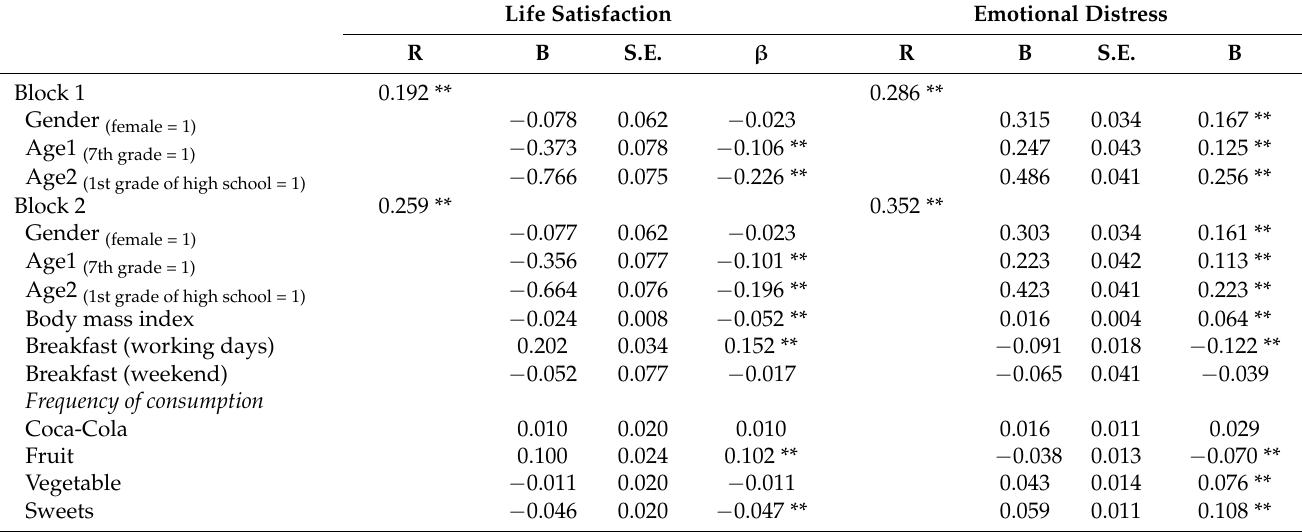
Table 4. Multiple Regression Analysis: Contribution of Eating Habits to Life Satisfaction and Emotional Distress. Life